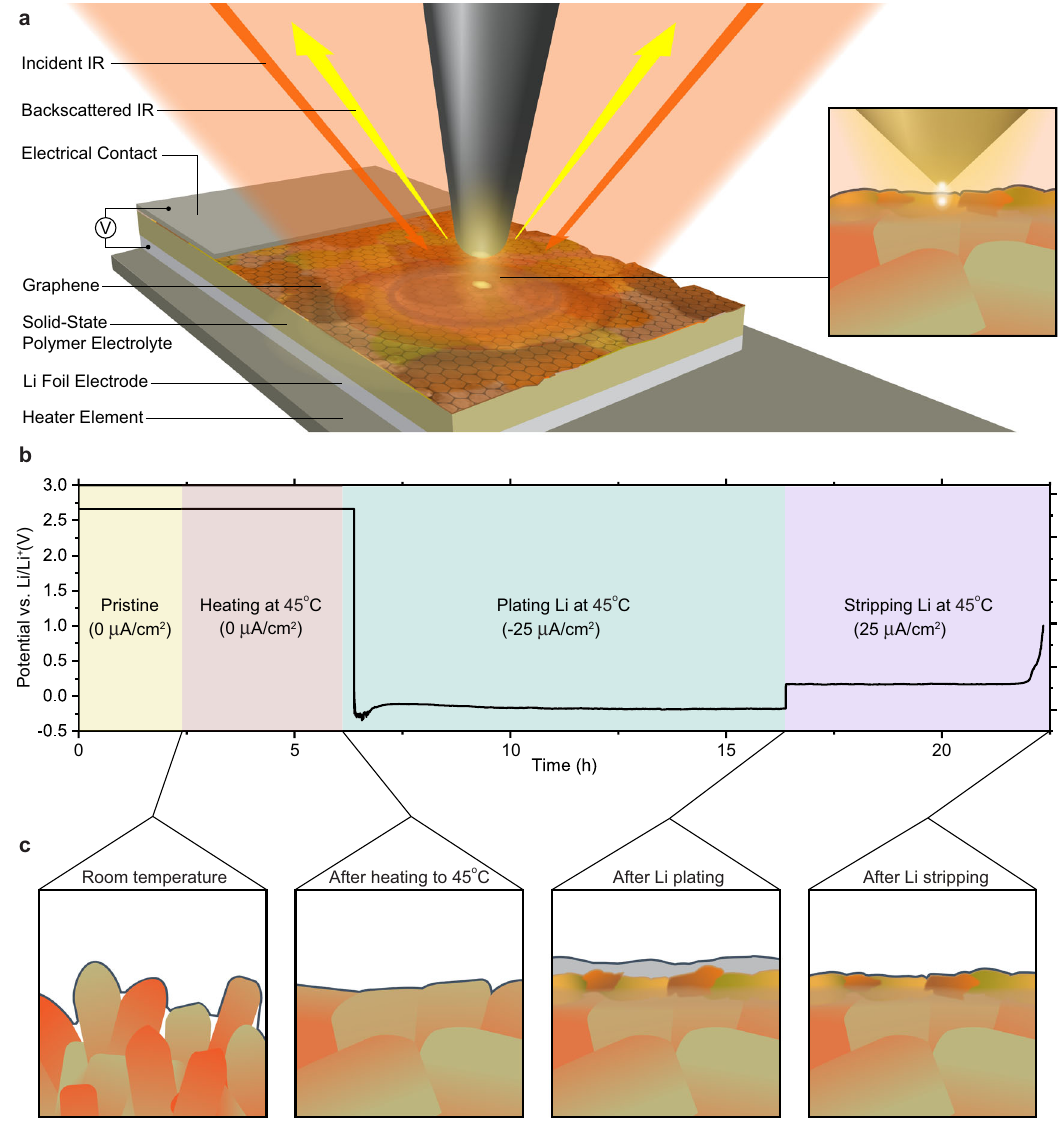
Fig. 1 Experimental setup and methodology for in situ near- fi eld infrared imaging and nanospectroscopy of the G/Li/polymer electrolyte interface. a 3-D schematic of the model battery cell atop heater element, including nano-FTIR probe (insert shows zoom in view of the probed area). b The electrode potential with respect to Li/Li + vs. time pro fi le for the experiment. c Cross-sectional illustrations of the interfacial region at four stages of cell